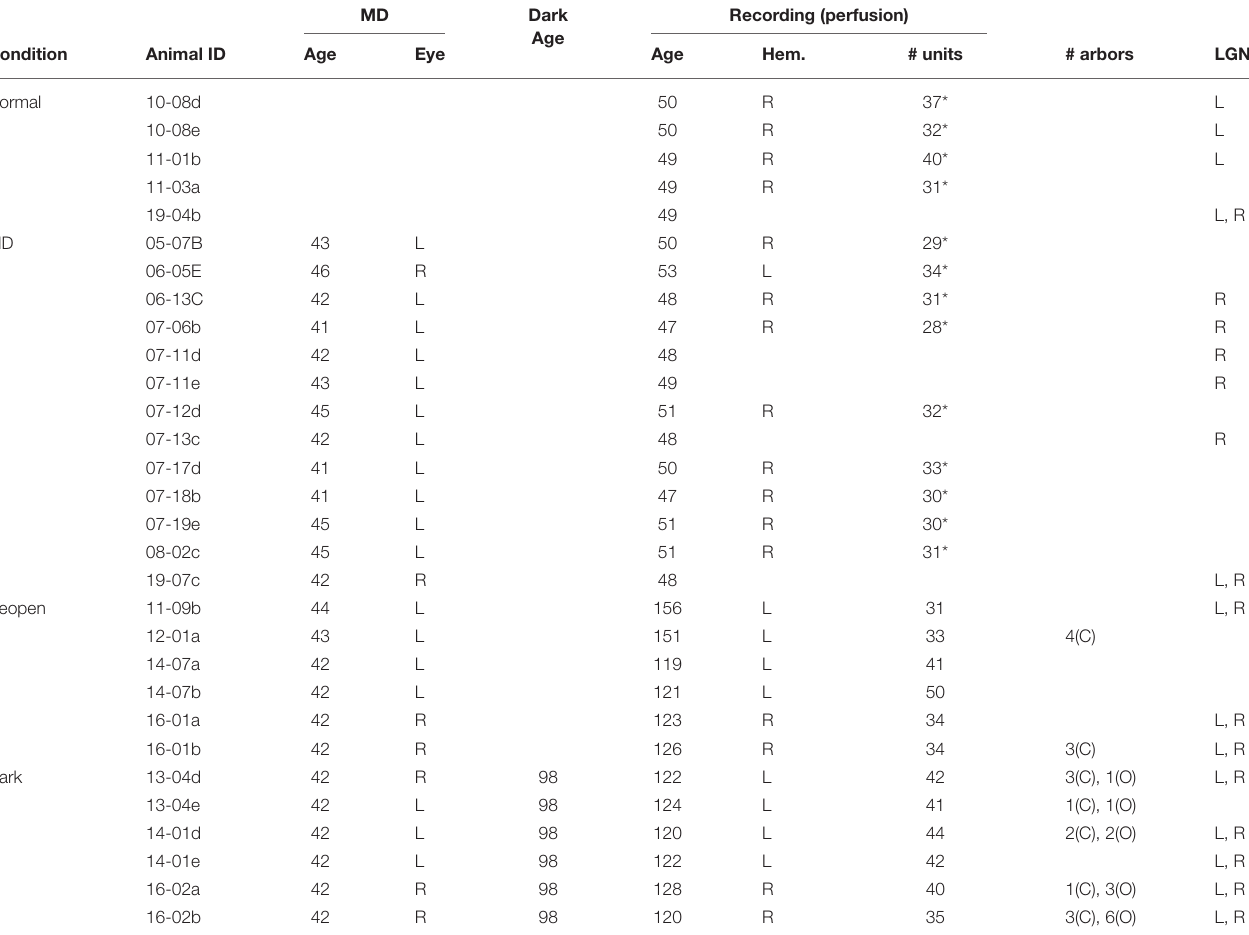
MD Dark Recording (perfusion) Age